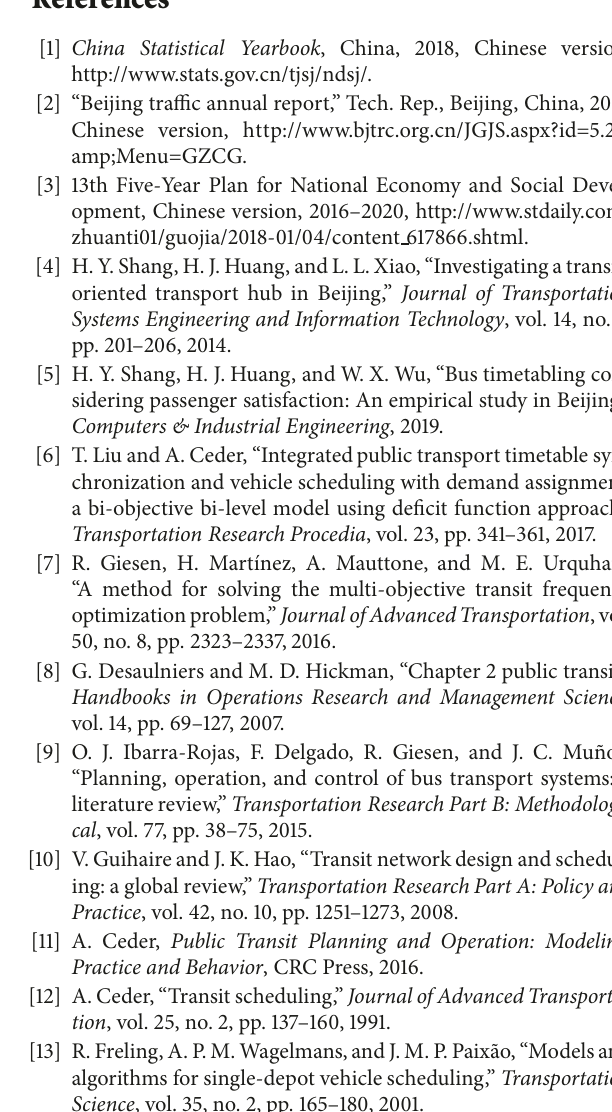
Table 6: Timetable for inserting DH